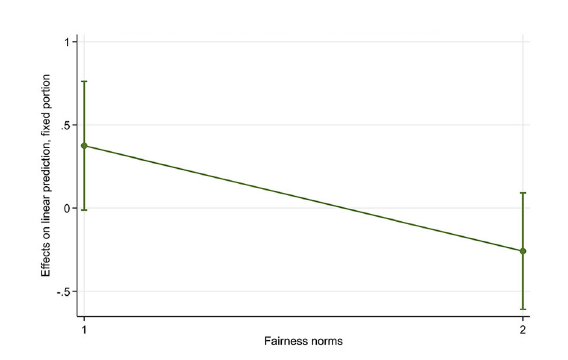
FIGURE4 Average marginal effects of the young man’s ethnicity, according to fairness norm-level, with 95% confidence intervals. to scrutinize the interactions’ average marginal effects. Figure 3 (for the interaction ethnicity x threat) and Figure 4 (for the interaction ethnicity x fairness norms) depict these average marginal effects. Figure 3 shows a downward trend. When threat is low, the old white man is more likely to call the police if the young man is a person of color than when he is white (ethnic discrimination). As the threat increases one level,